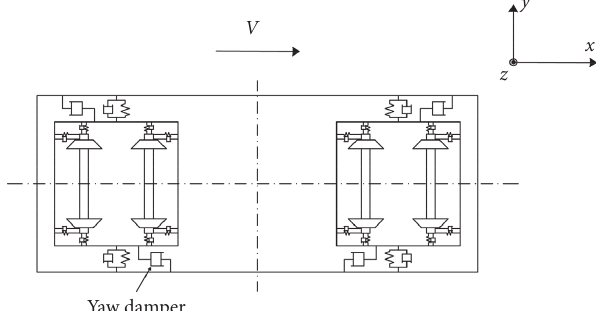
Figure 1: Installation position of the yaw